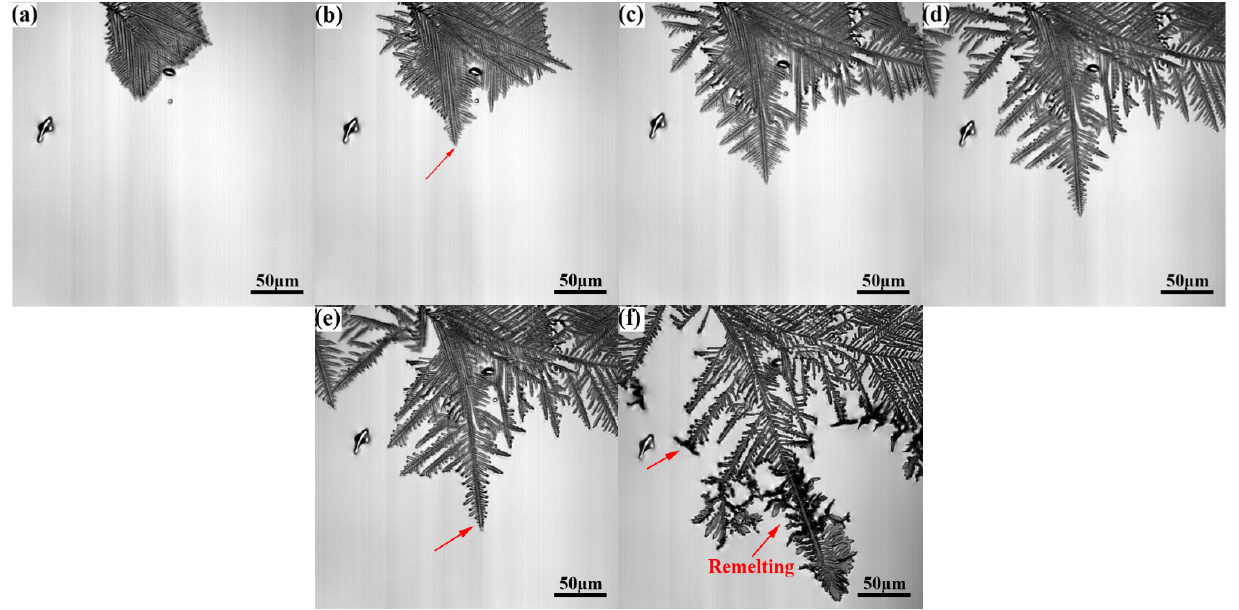
Figure 5. γ -Fe dendrite microstructure evolution during solidification at the cooling rate of 0.3 ◦ C/s: ( a ), 1286.5 ◦ C, ( b ) 1286.2 ◦ C, ( c ) 1285.9 ◦ C, ( d ) 1285.6 ◦ C, ( e ) 1285.3 ◦ C, and ( f ) 1282.8 ◦ C.